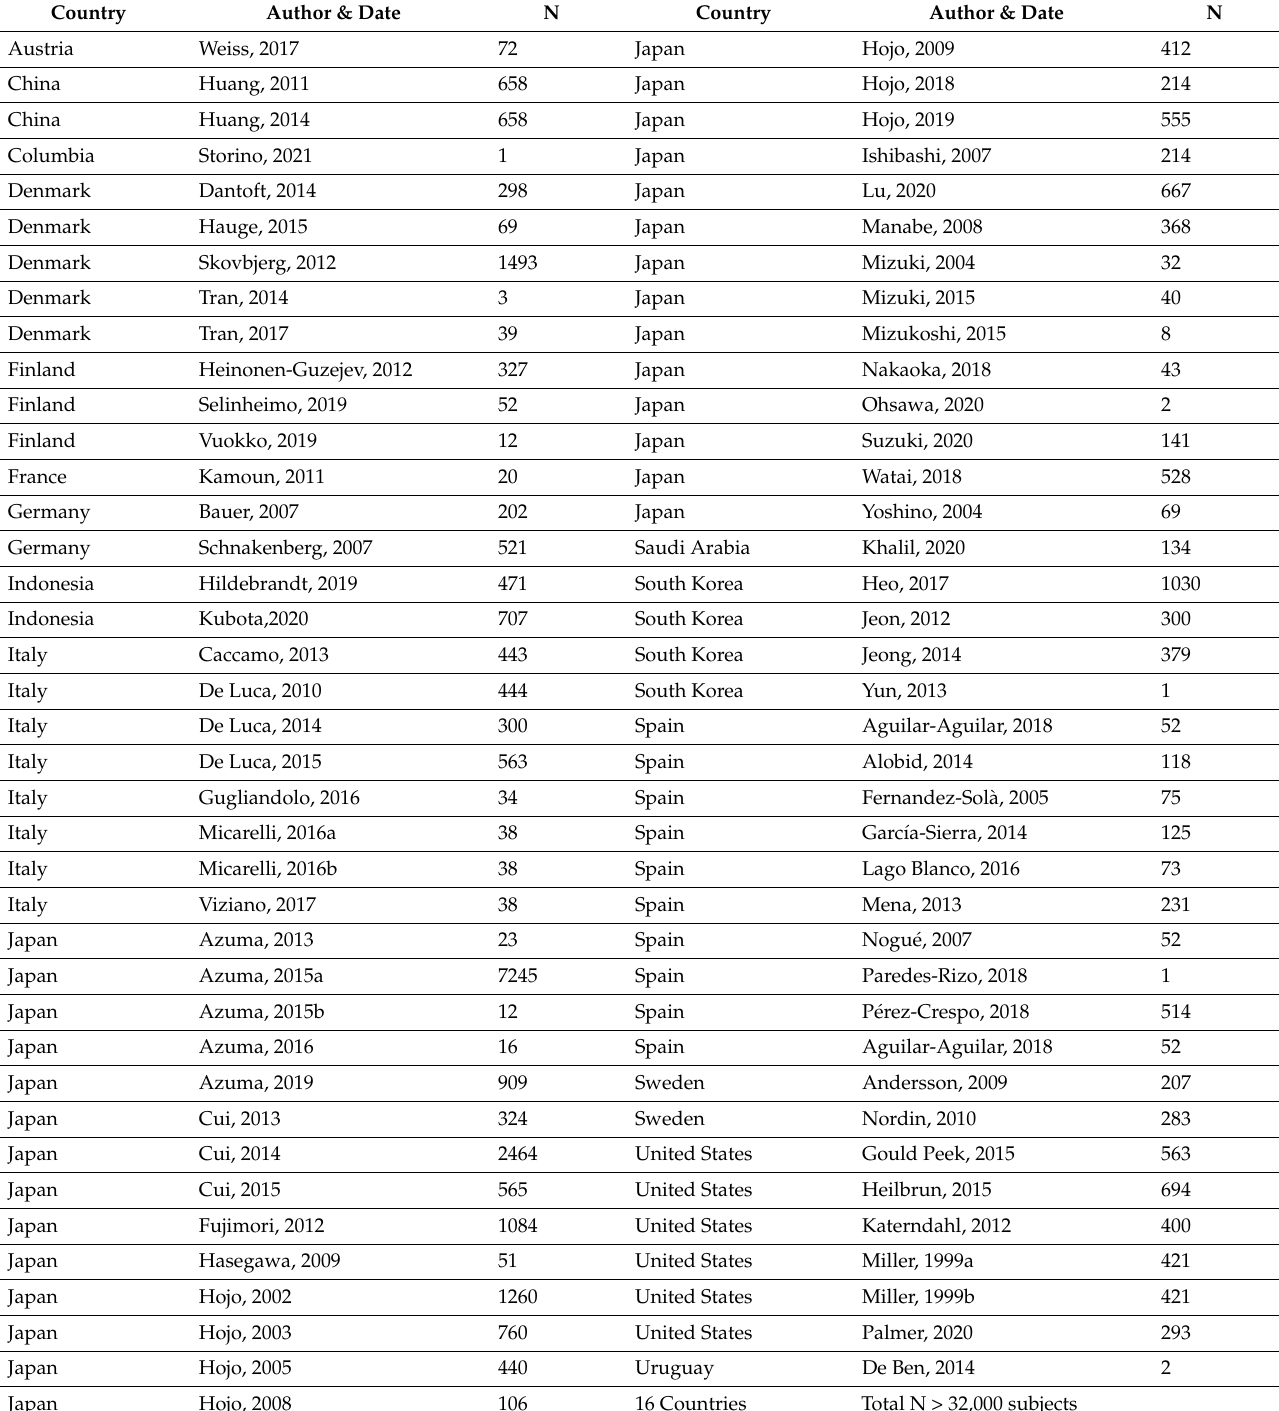
Table 1. Peer-reviewed Journal Articles Using the QEESI by